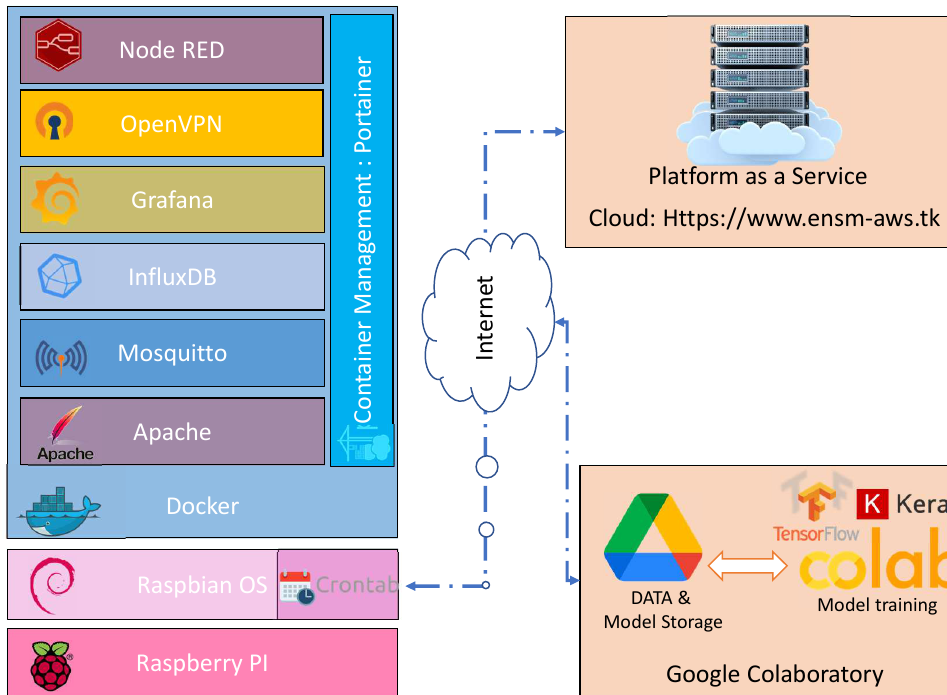
Figure 6. Overview on Docker’s containers and interaction with cloud and